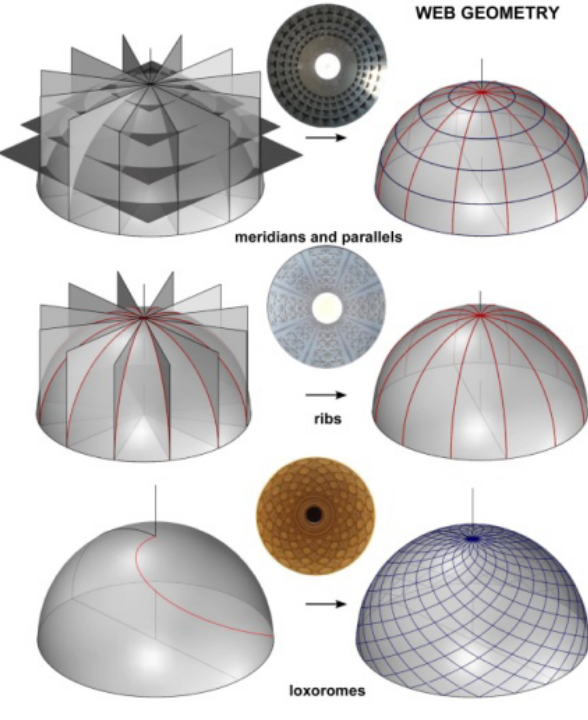
Figure 1. Hemispherical domes: grid geometry for coffers